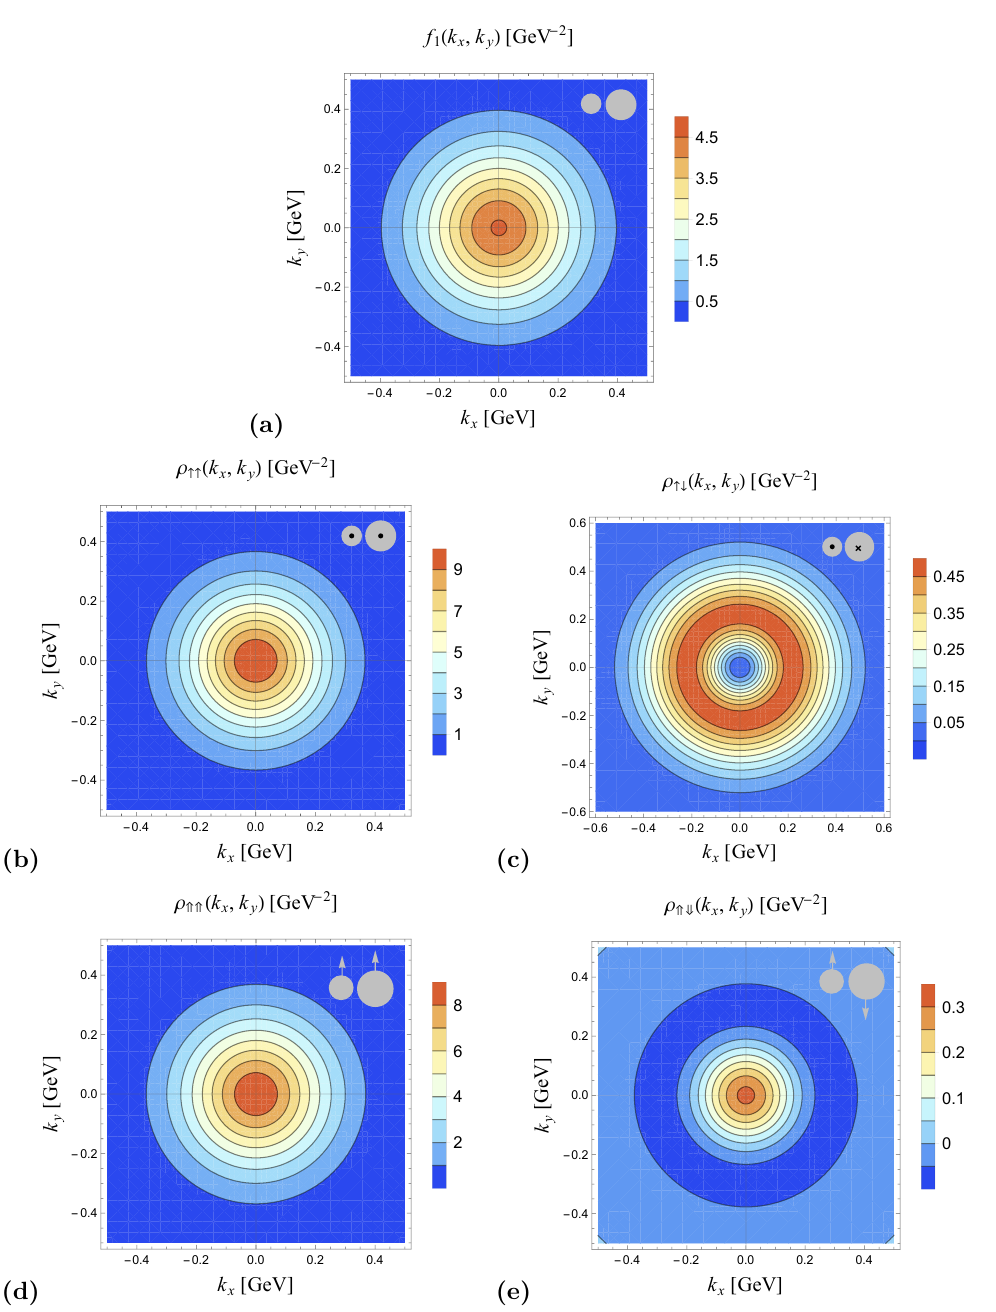
Figure 10 . (Color online) Quark density plots for f 1 ( k x , k y ) (upper panel); ρ ↑↑ ( k x , k y ) , ρ ↑↓ ( k x , k y ) (middle panel) and ρ ⇑⇑ ( k x , k y ) , ρ ⇑⇓ ( k x , k y ) (lower panel) in the momentum plane. The gray colored vacant small and large circles (upper right corner) corresponds to both quark and the ρ -meson being unpolarized. The dot and cross inside the circles denote the longitudinal polarization in same and opposite directions respectively. The arrow along upward and downward directions symbolize the transverse polarization of the quark and the ρ